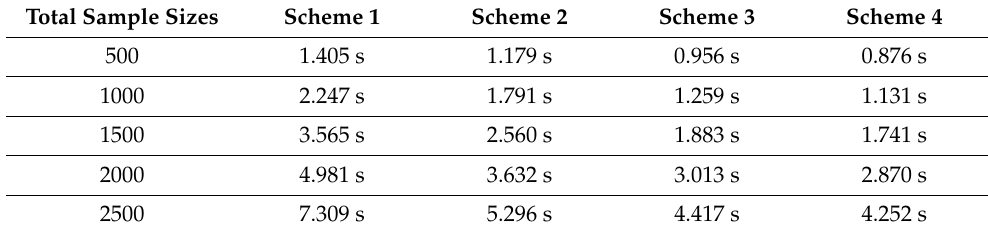
Table 3. The performing times on the FPGA platform.